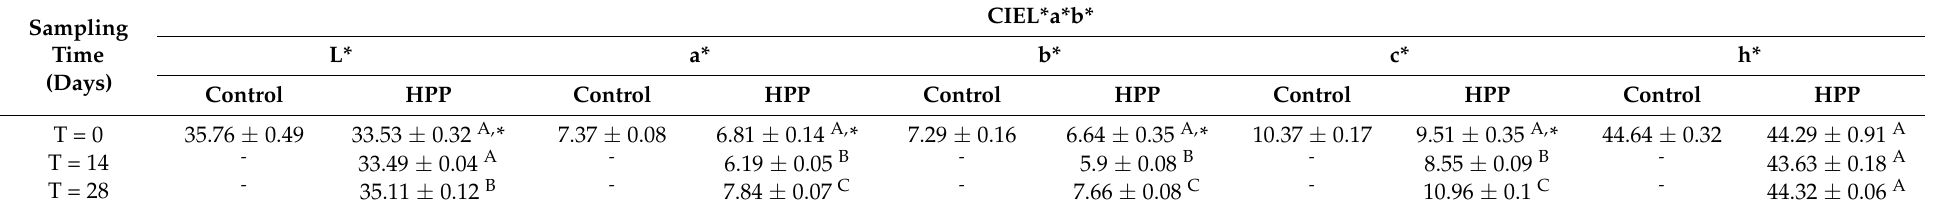
Table 4. Color measurements of the